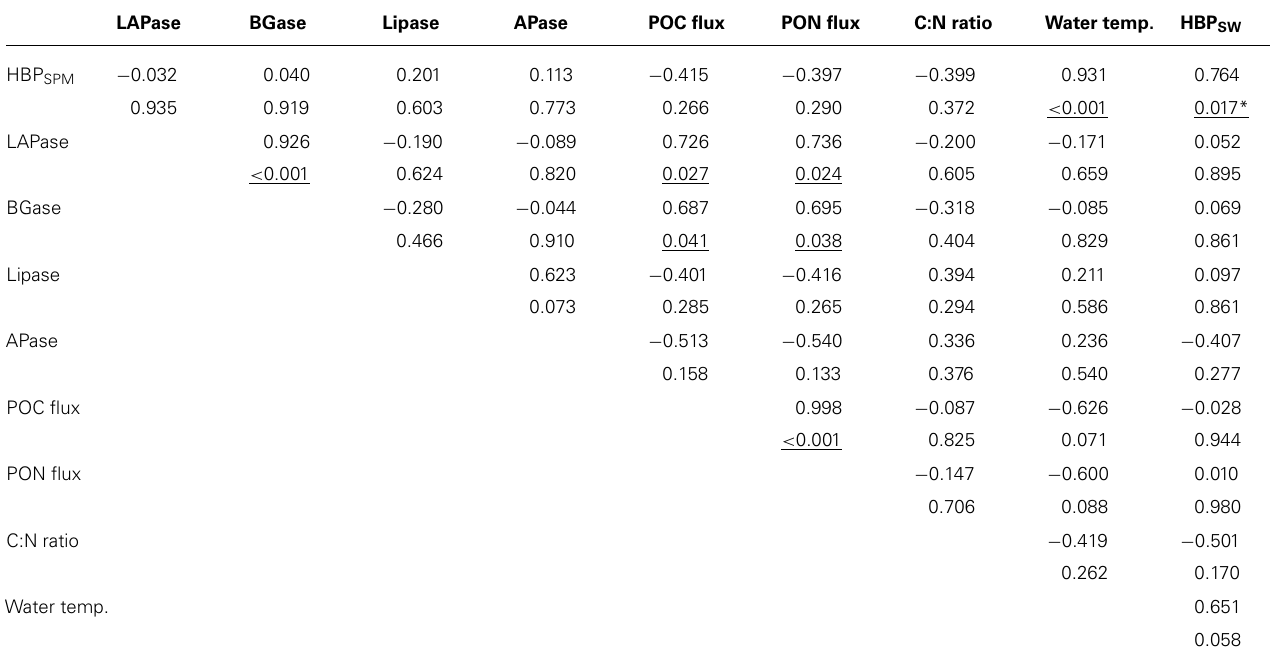
Table 3 | Pearson product-moment correlation matrix comparing variables measured in SPM (HBP SPM , EEA, POC and PON fluxes, and C:N ratio) and in seawater (water temperature and HBP SW